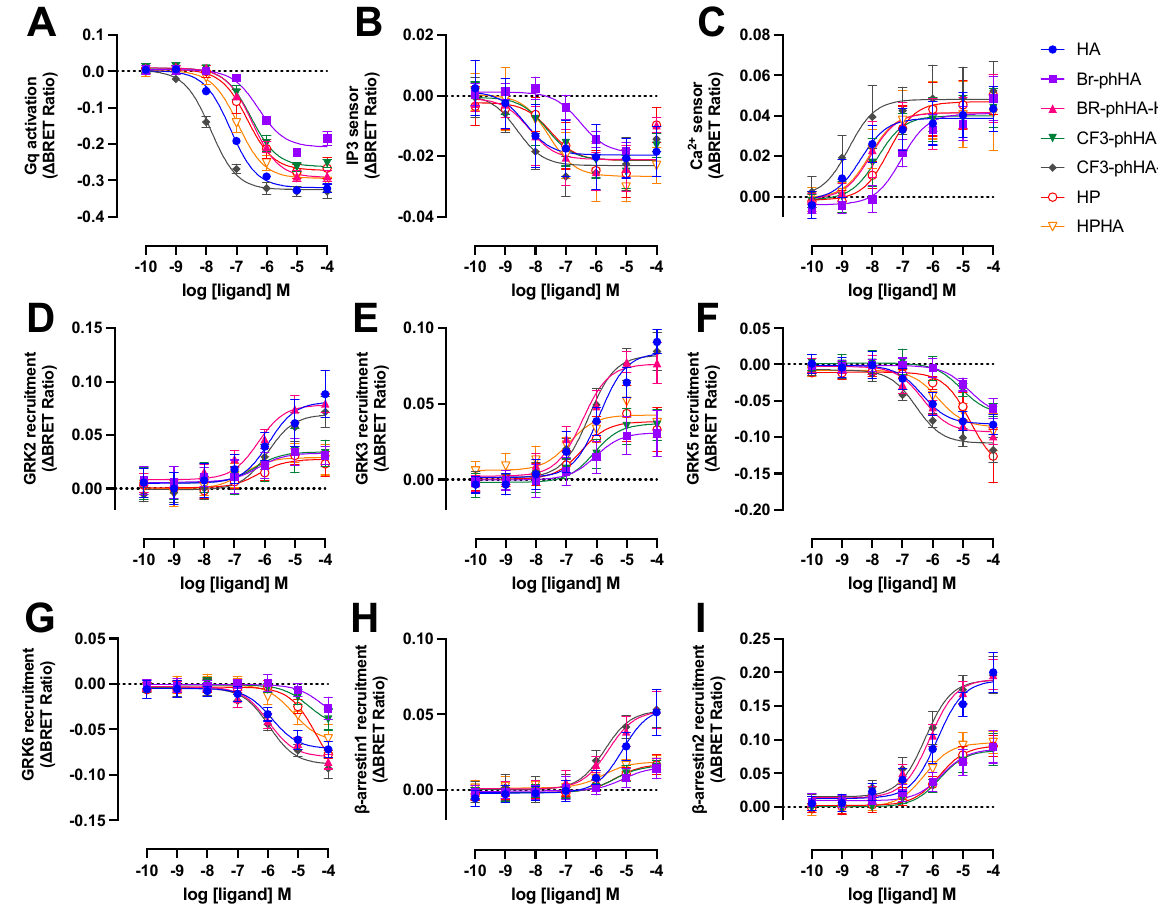
Figure 5. Concentration response curves of BRET-based responses in HEK293T cells upon stimulation with various H 1 R agonists. BRET measurements in HEK293T cells transiently co-expressing H 1 R (0.5–1.0 µ g plasmid/dish) in combination with G q activation sensor (2.5 µ g plasmid/dish) ( A ), InsP 3 ( B ) or Ca 2+ ( C ) sensor (4.0 µ g plasmid/dish), or H 1 R-Rluc8 (1.0 µ g plasmid/dish) in combination with GRK2-mVenus ( D ), GRK3-mVenus ( E ), GRK5-mVenus ( F ), GRK6-mVenus ( G ), β -arrestin1-eYFP ( H ), or β -arrestin2-mVenus ( I ) (4.0 µ g plasmid/dish), upon stimulation with increasing concentrations agonist for 20 ( A – C )or 60 min ( D – I ). Data are shown as mean ± SD from at least three independent experiments performed in triplicate.